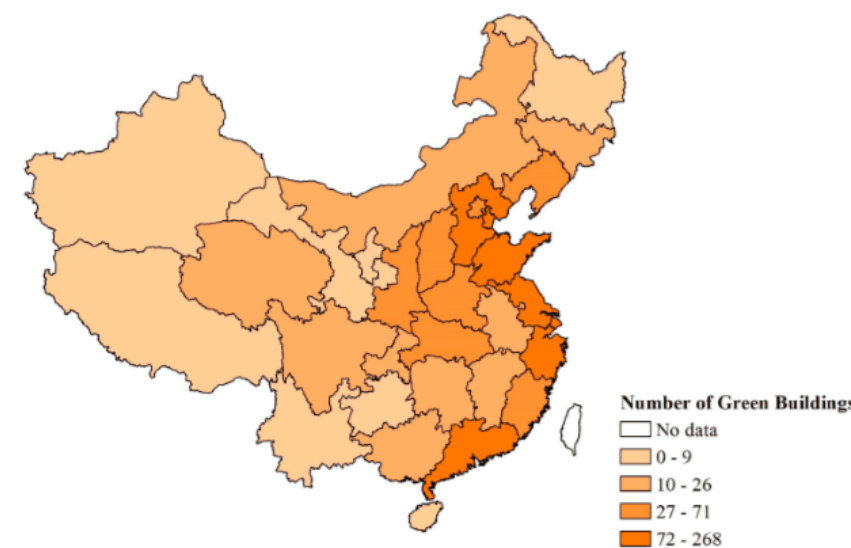
Figure 1. Distribution of green residential buildings in 2015.